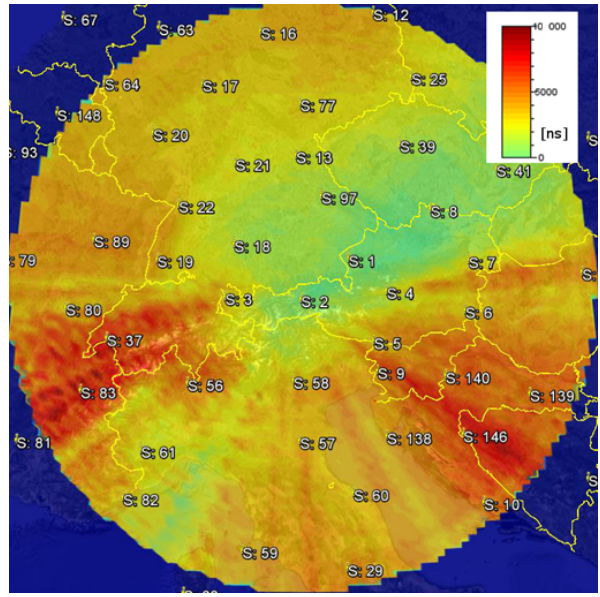
Figure 2. Example of a propagation correction determined and im- plemented for Austrian sensor #2 (Schwaz). The sensor is located in the center of the circular